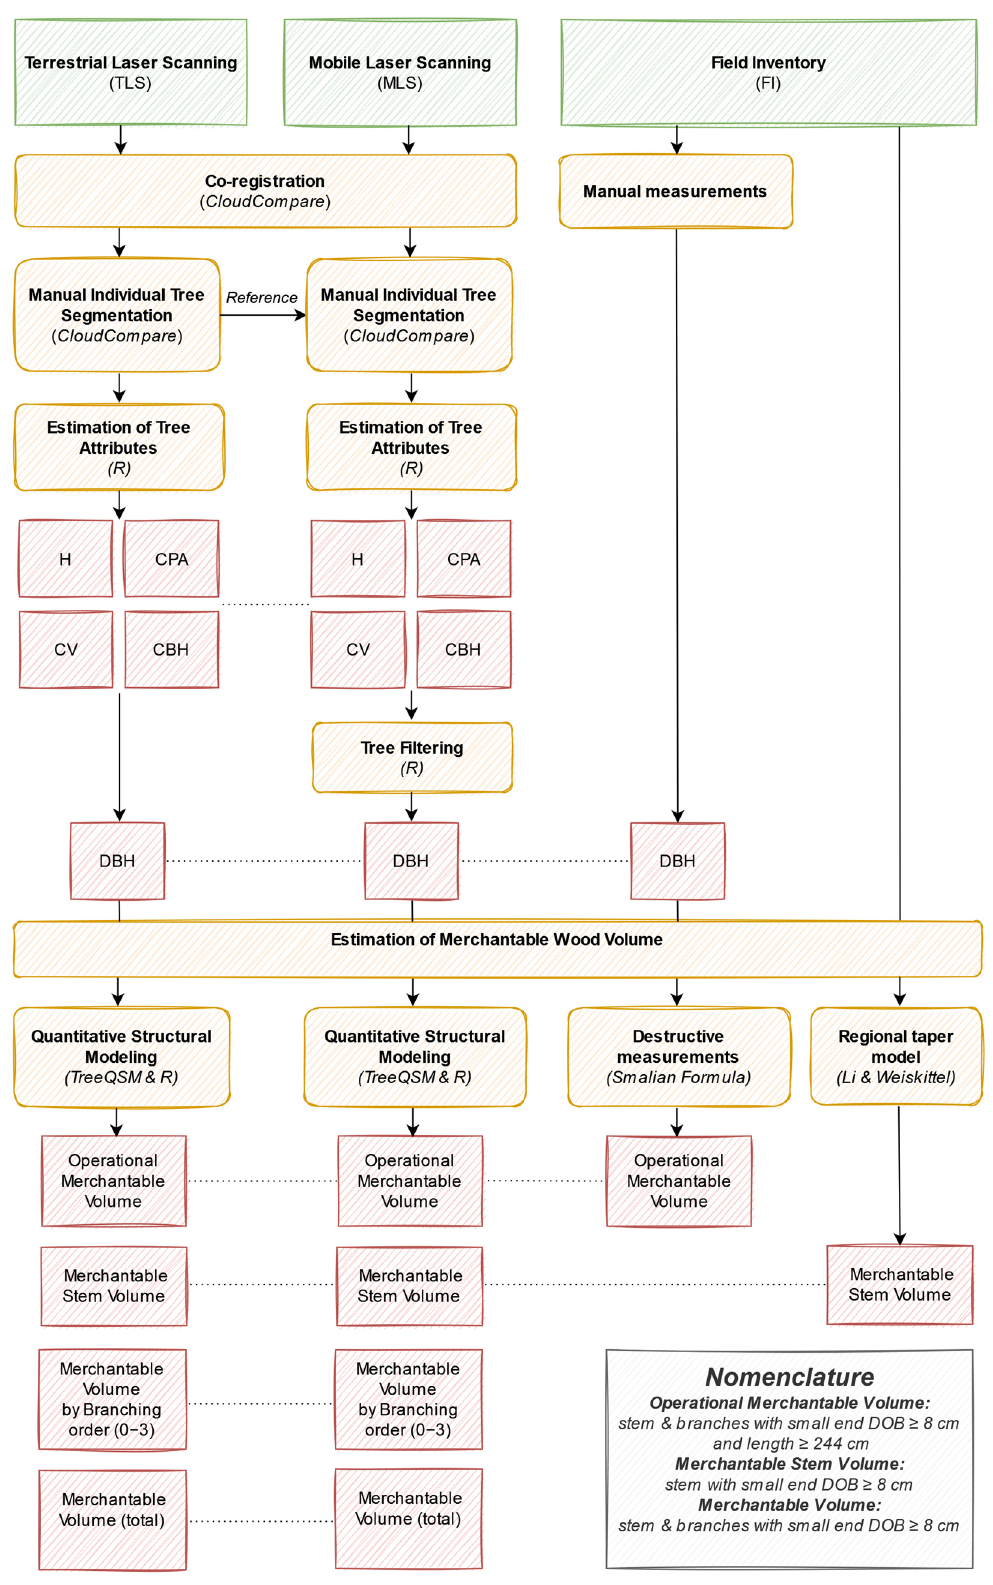
Figure 3. Overall data processing workflow for TLS, MLS, and field measurements (green: input; orange: processing; red: output; italic: software and formula). Acronyms: height (H), crown projected area (CPA), crown volume (CV), crown base height CBH), diameter at breast height (DBH), and diameter outside bark (DOB).